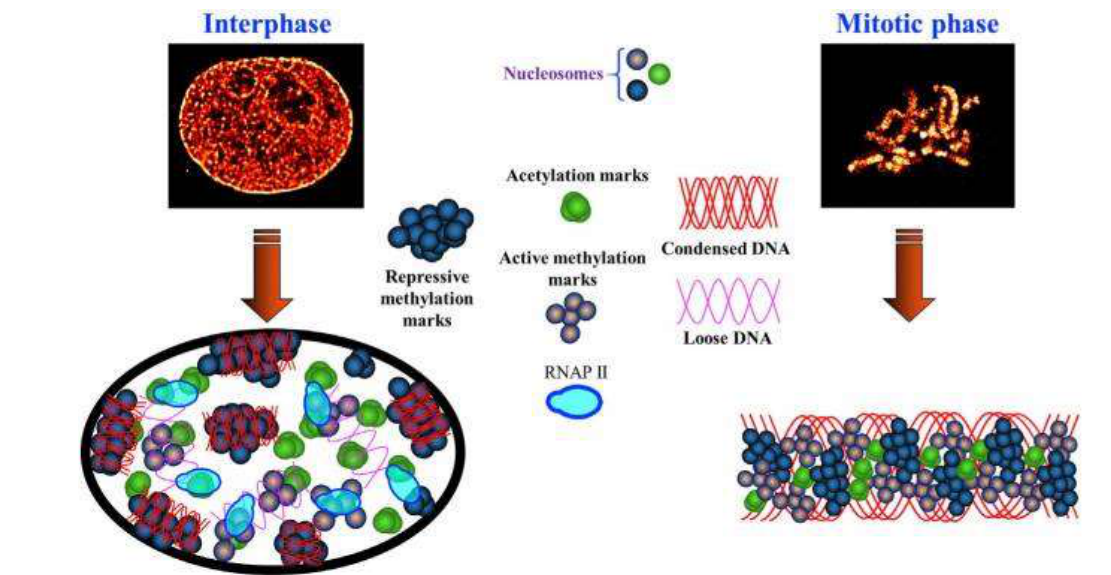
Figure 6. Model to illustrate the spatial organization of the chromatin environment at interphase and mitotic phases. Three distinct structural groups of active histone acetylation, active histone methylation, and repressive histone methylation, as well as their spatial relationship with active transcription machinery are shown. Modified from [91].